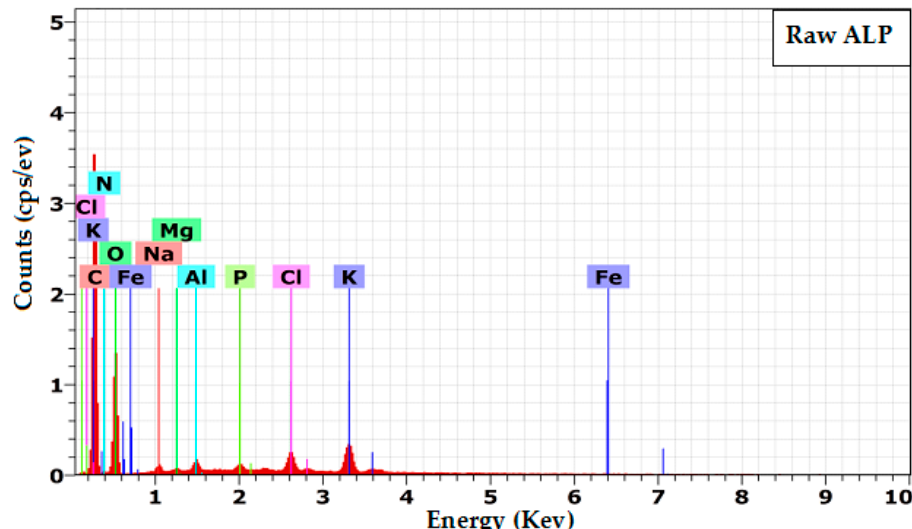
Figure 4. Energy Dispersive Spectroscopy (EDX) for raw material.